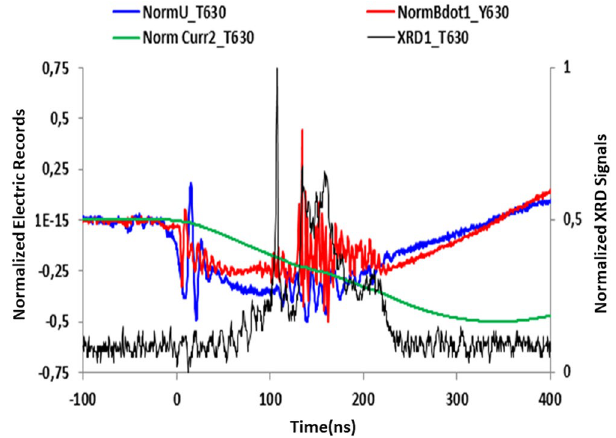
Figure 1. Close-up of the electrical and photonic records 500 ns around the time of pinching (shot XP _630). The electrical records (voltage, B -dot probe signal, current as numerically integrated from B -dot) are normalized ( − 1 to 1) to their span over the whole shot (left scale). X -ray signal is figured out by the XRD signal in volt (right scale), normalized (0 to 1). Close after the x -ray emission, a rise of the inductance leads to a current